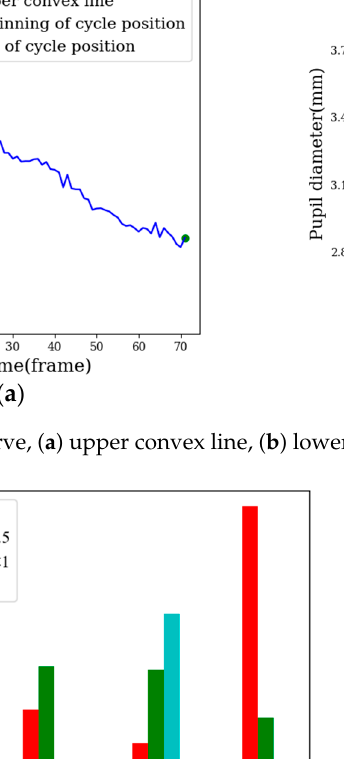
Figure 3. Cycle curve, ( a ) upper convex line, ( b ) lower convex line.